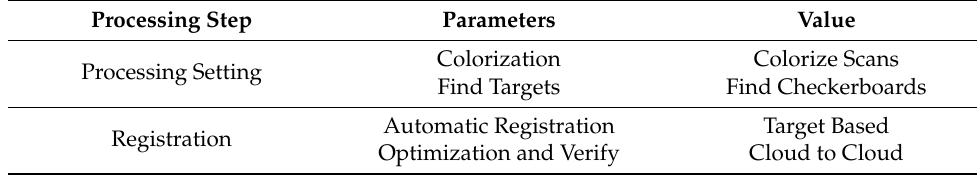
Table 4. SCENE Setting